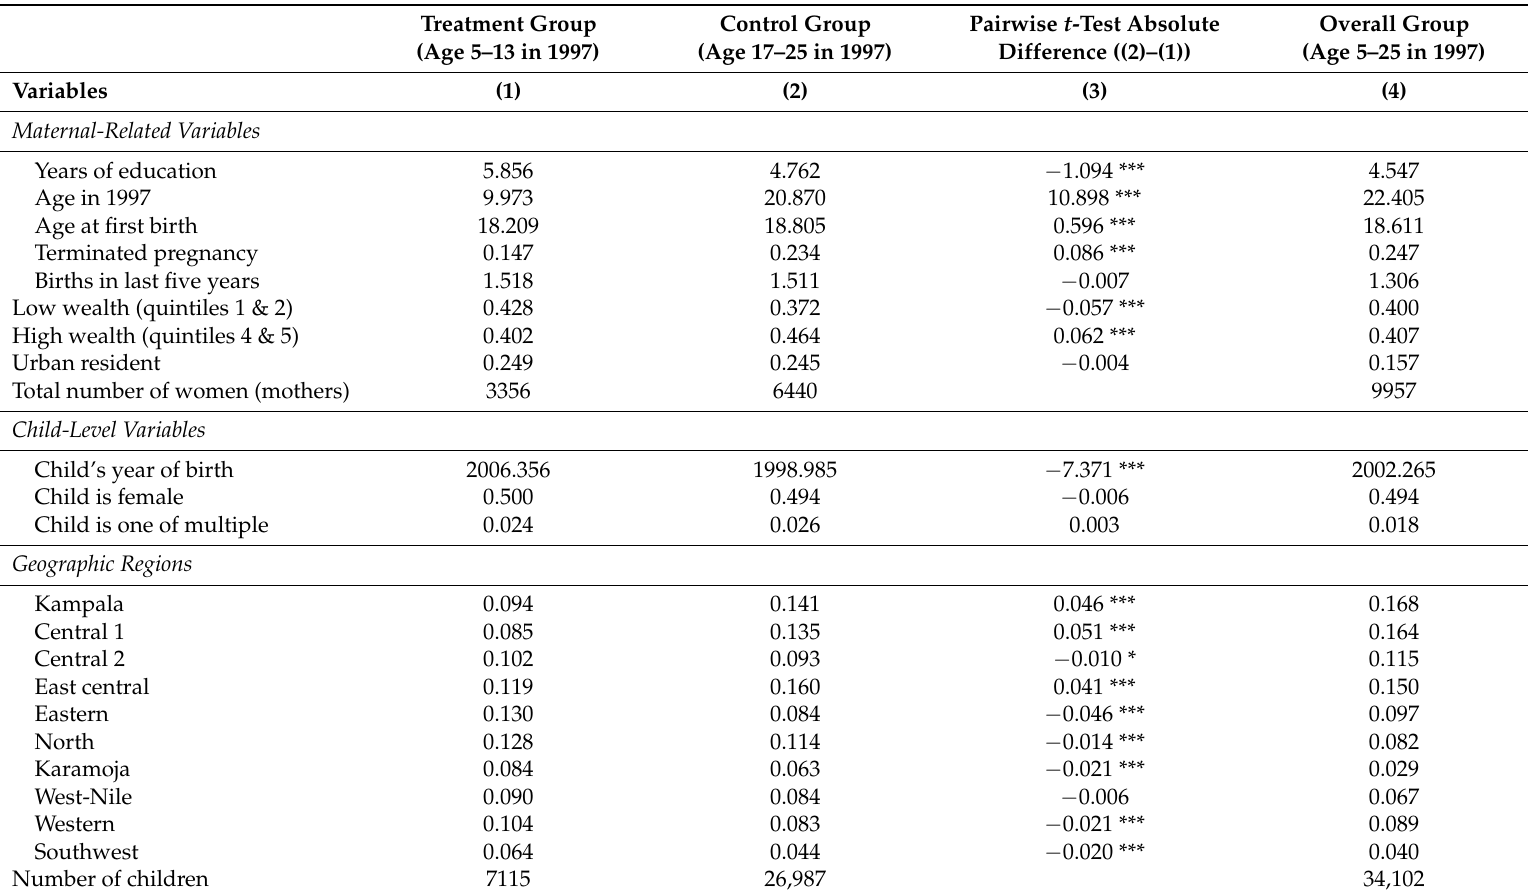
Table 1. Descriptive statistics of selected